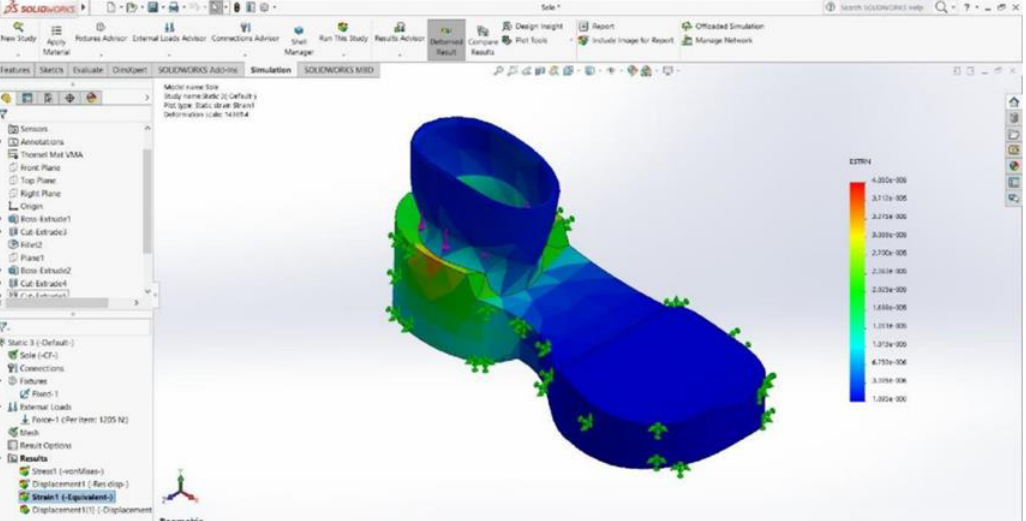
Figure 11. Total